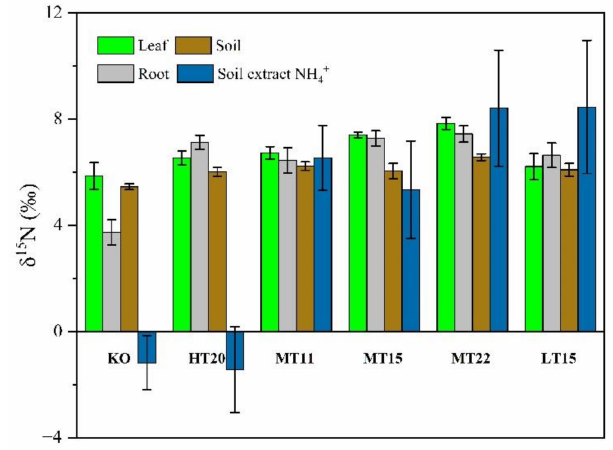
Figure 4. Comparisons of foliar, root and soil δ 15 N and soil-extracted NH 4+ δ 15 N among different sampling